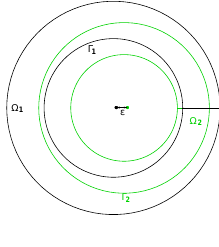
Figure 3. Subdomains of the first model